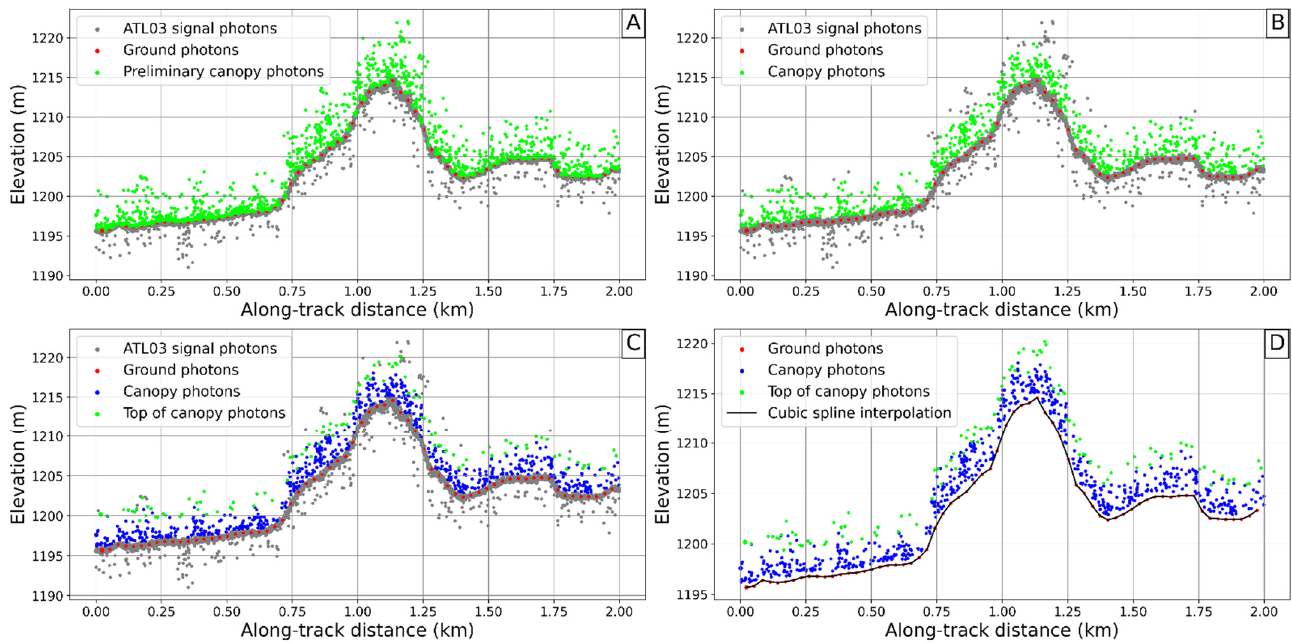
Figure 6. Characteristic filtering steps of a canopy classification exemplified on the strong beam,